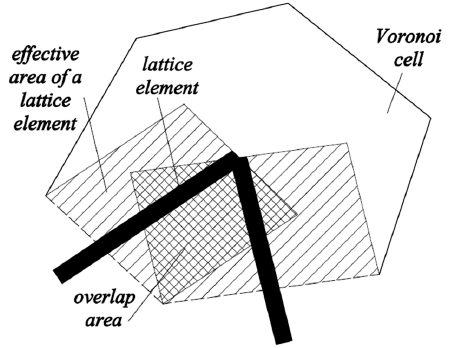
Figure 5. Definition of overlap area for determination of parameter ω (adapted from [34]).